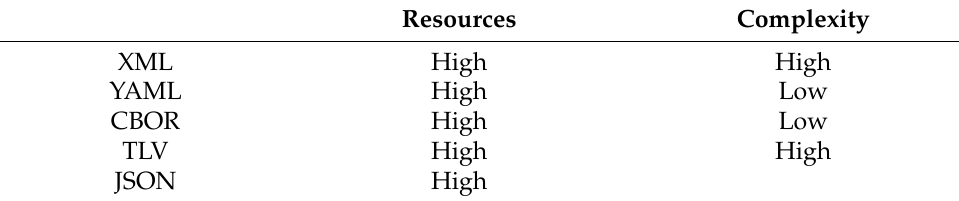
Table 7. Comparison of data serialization and formatting technologies.